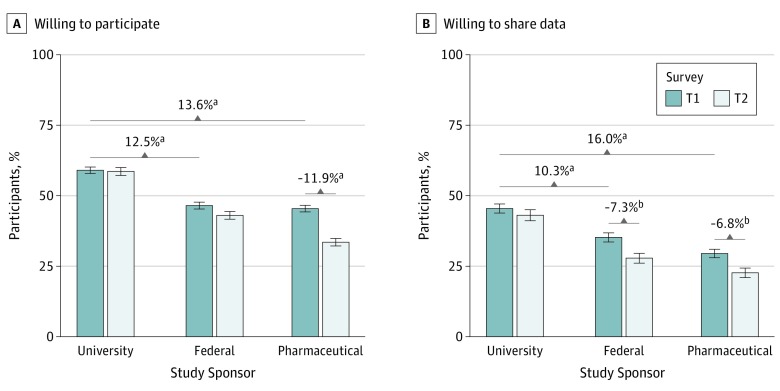
Proportion of Participants Willing to Participate and Share Their Social Media DataProportions of participants willing to participate in biomedical research (A) and share their social media data for biomedical research (B) in the first survey (T1) and the second survey (T2). Error bars indicate bootstrapped estimates of variations in participants' responses (1 SD).aStatistically significant at false discovery rate–corrected P < .001.bStatistically significant at false discovery rate–corrected P < .05.